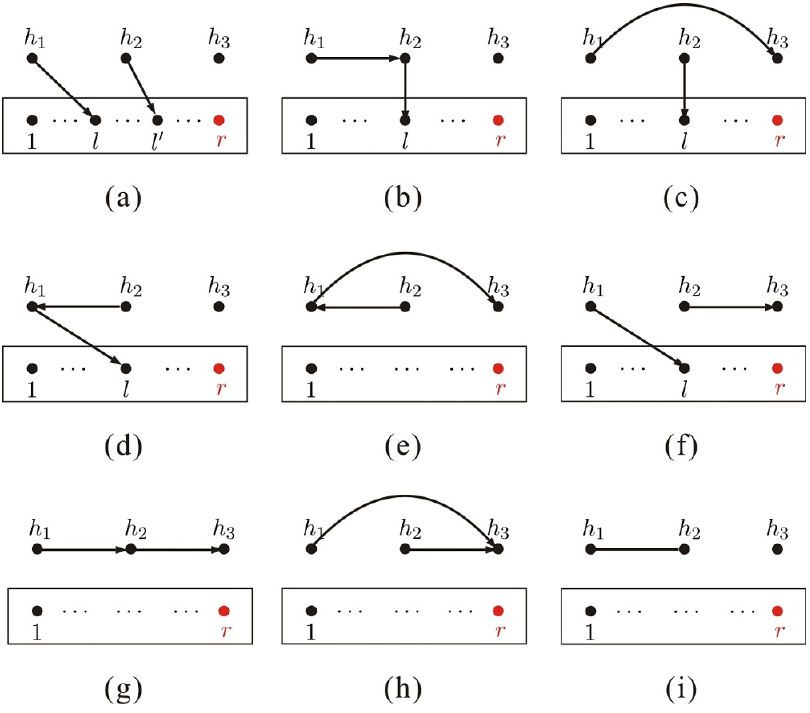
Figure 6 . All skeletons for the gauge invariance induced identity with H = f h 1 ; h 2 ; h 3 g .